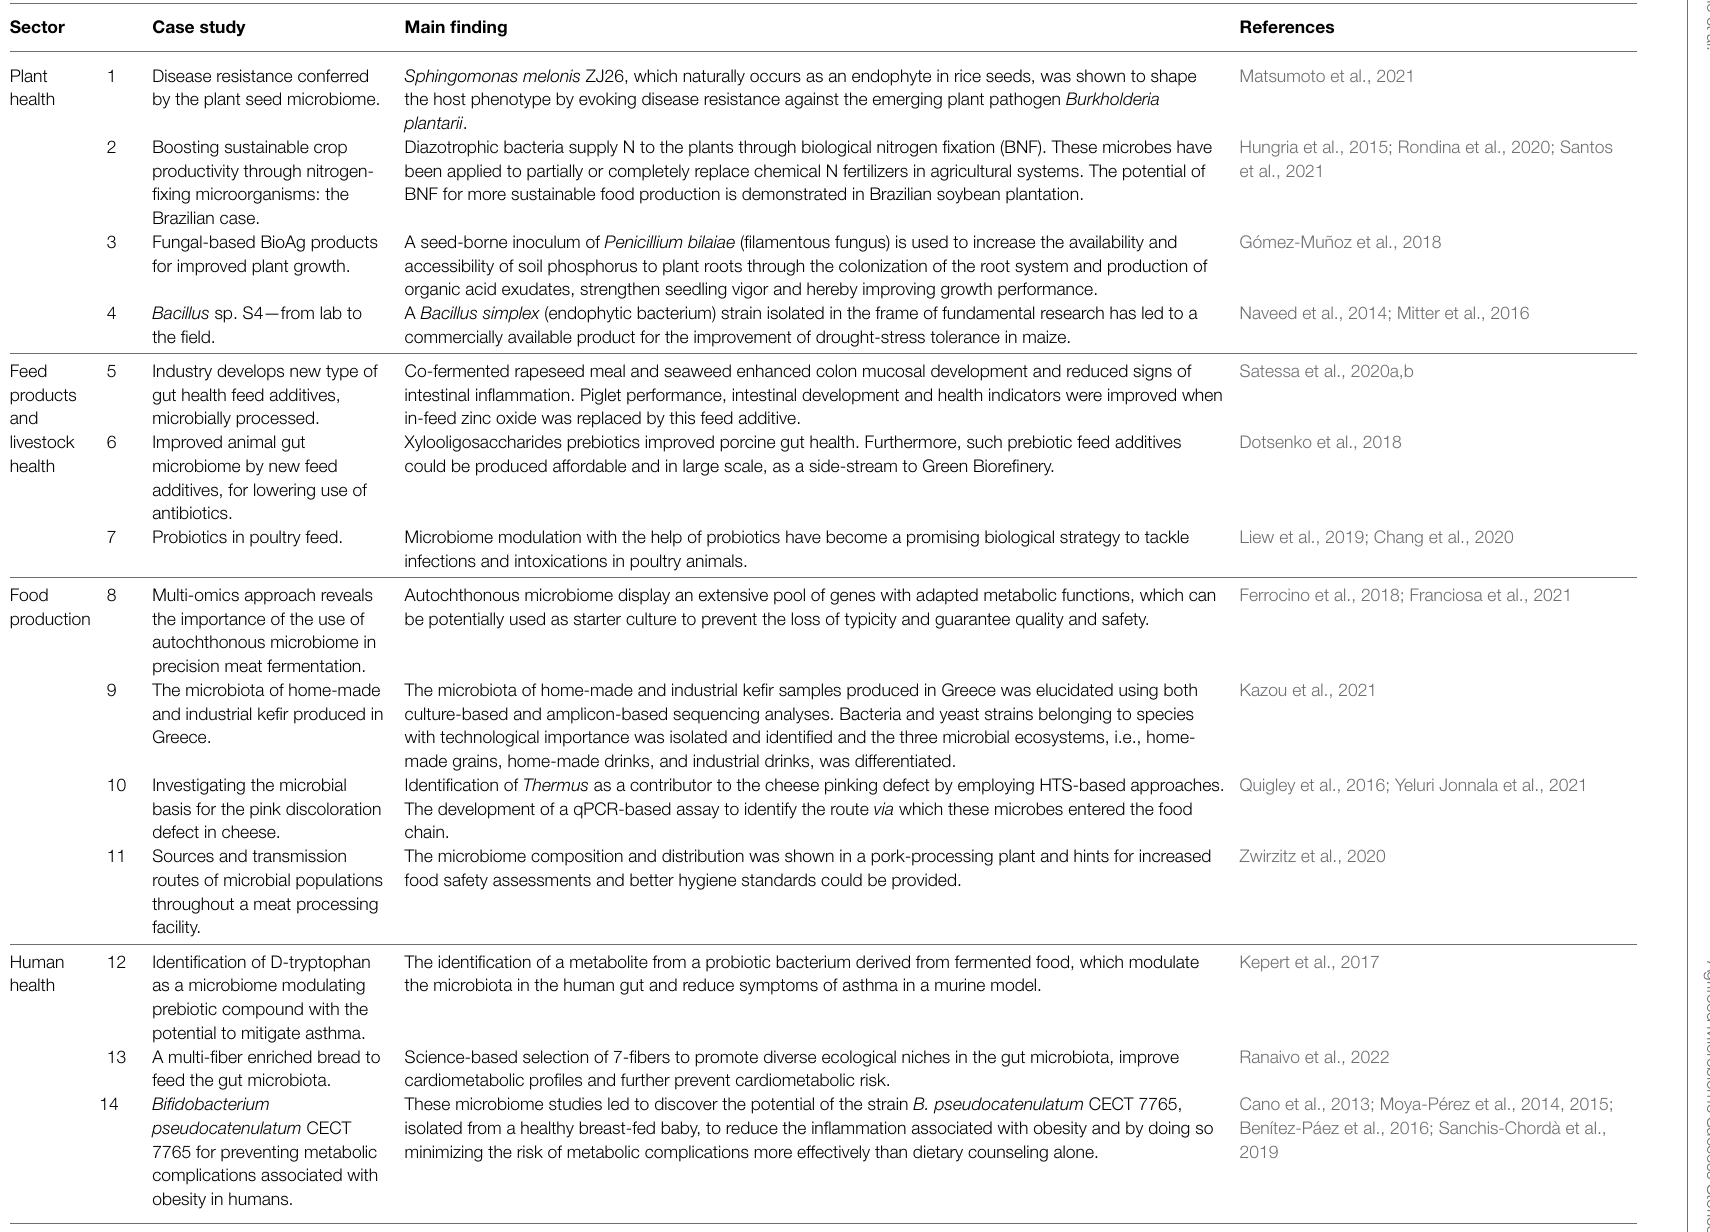
TABLE 1 | Case studies addressed in the manuscript organized into different sectors and their main findings and references. Sector Case